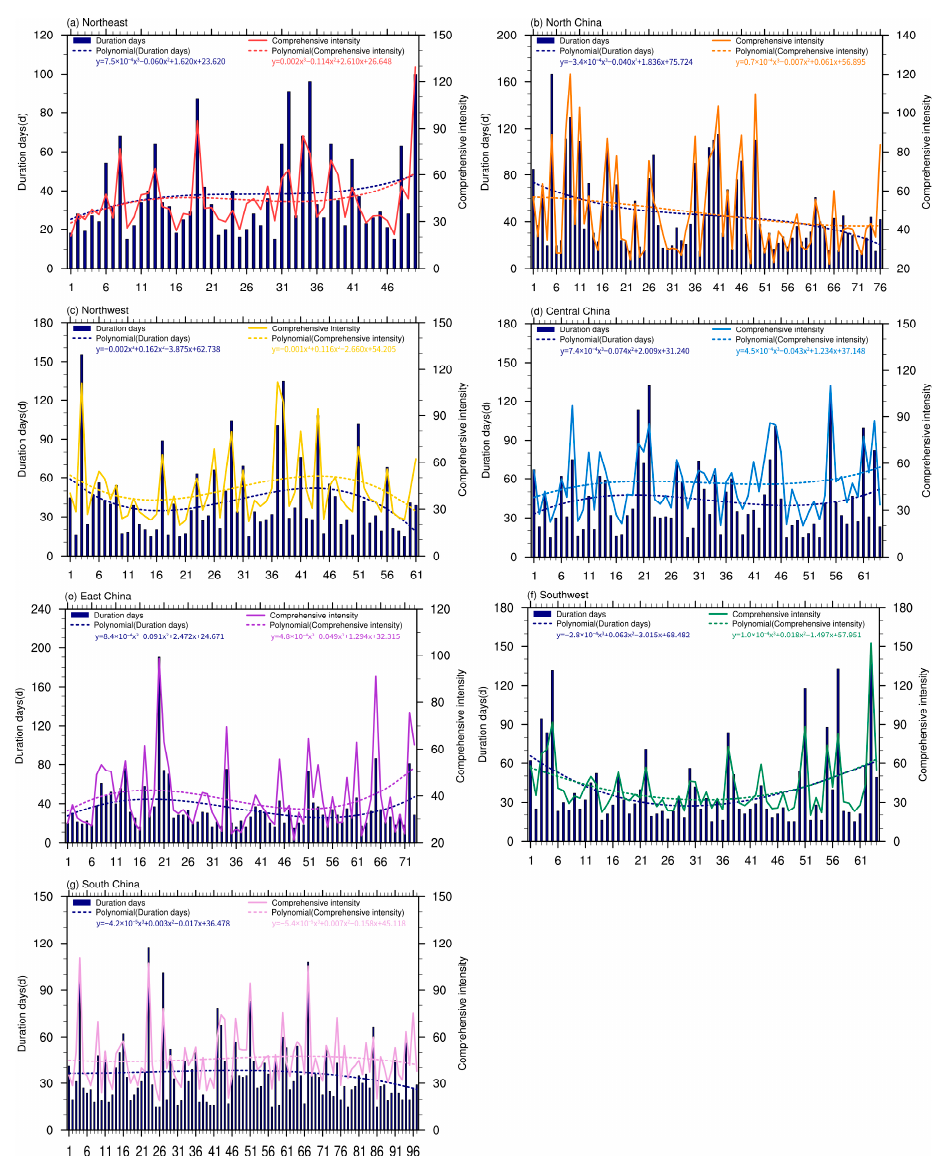
Figure 7. ( a – g ) Variation of duration and comprehensive intensity of regional drought processes in China 1961 to